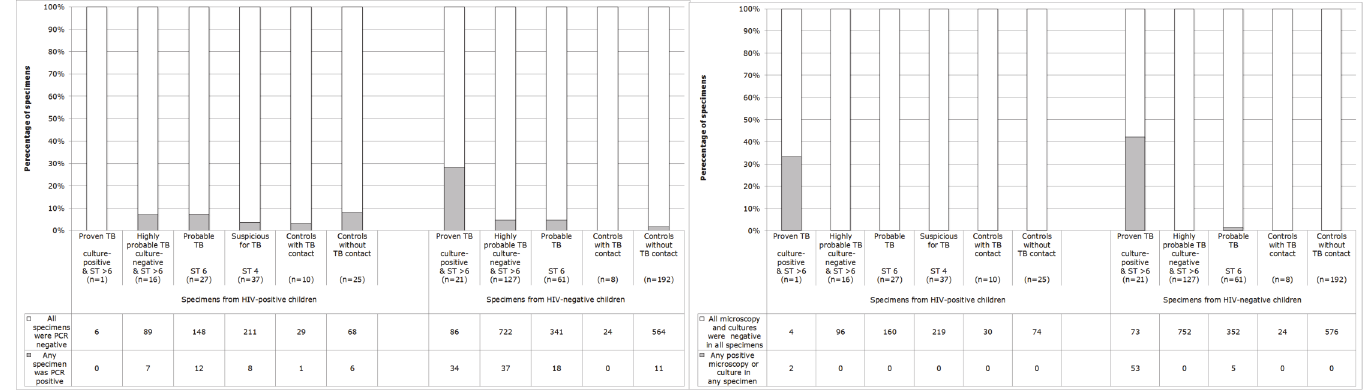
Fig 2. Tuberculosis (TB) test results for specimens from HIV-positive and HIV-negative case and well-control children. Data are analysed by assessment of probability of TB disease indicated by the Stegen-Toledo (ST) clinical score (see Methods). (A) TB PCR results. (B) Microscopy and culture test results: auramine microscopy, microscopic-observation drug-susceptibility (MODS) liquid culture, and Lowenstein Jensen solid culture.